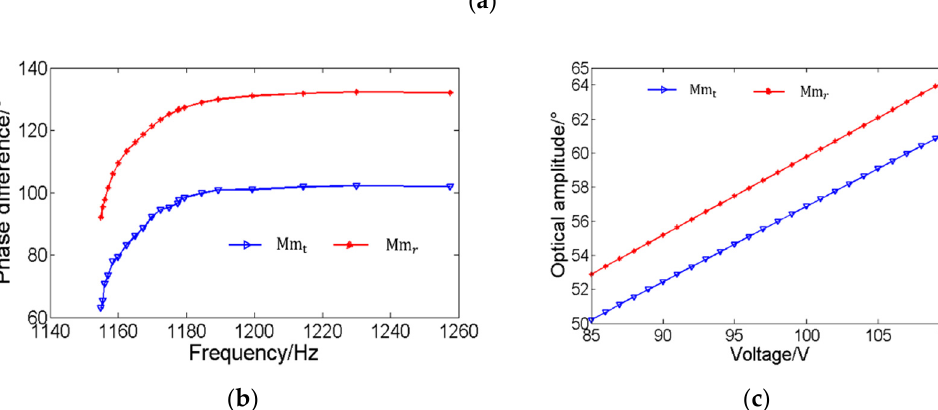
Figure 6. ( a ) The amplitude-frequency characteristic; ( b ) the phase-frequency characteristic; ( c ) the relationship between the scan amplitude and drive voltage.